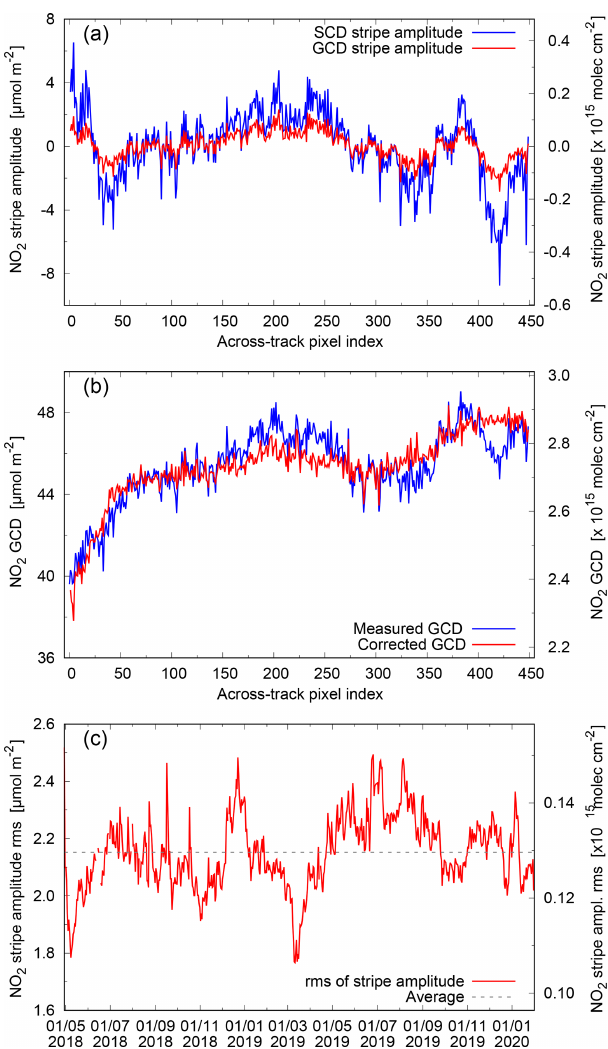
Figure 4. Evaluation of the NO 2 SCD stripe amplitude. (a) SCD stripe amplitude N str s (blue) and N str s /M geo , i.e. the GCD stripe amplitude (red), for orbit 03711 of 1 July 2018. (b) The measured (blue) and corrected (red) GCD for the same orbit, averaged over the TL range. (c) Time evolution of the rms of the SCD stripe am-